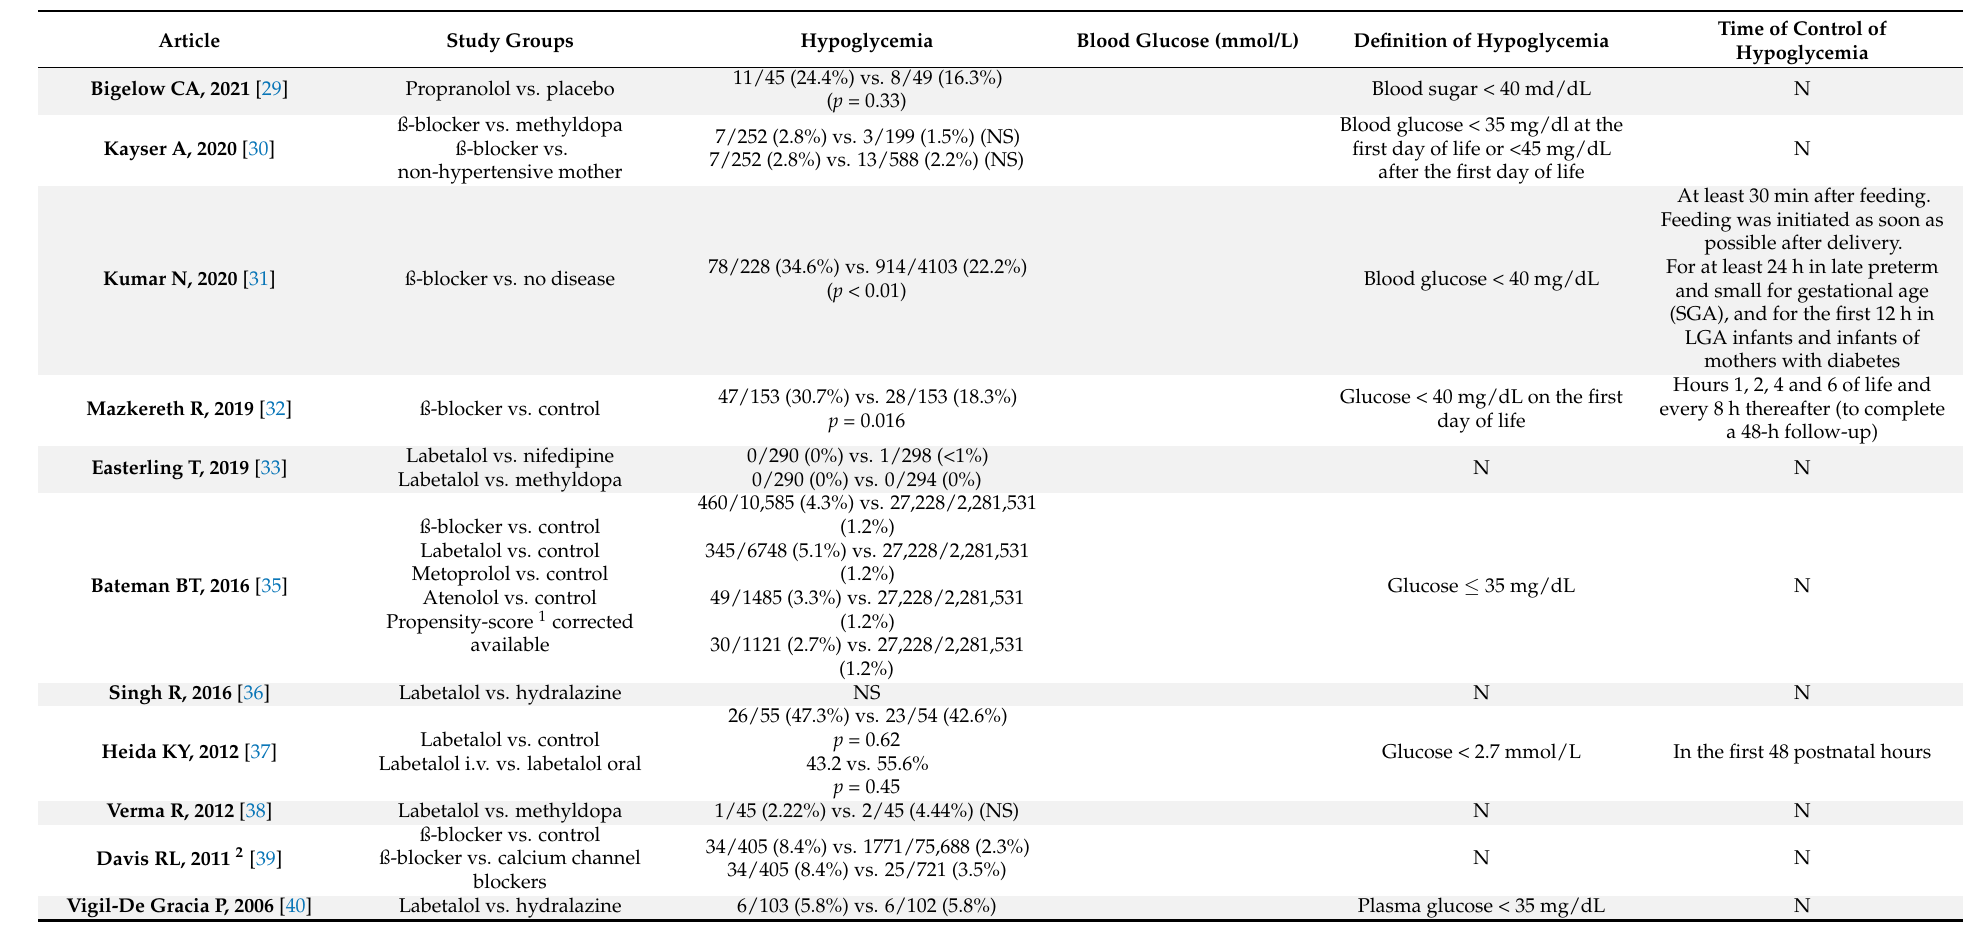
Table 10. Studies with hypoglycemia as outcome